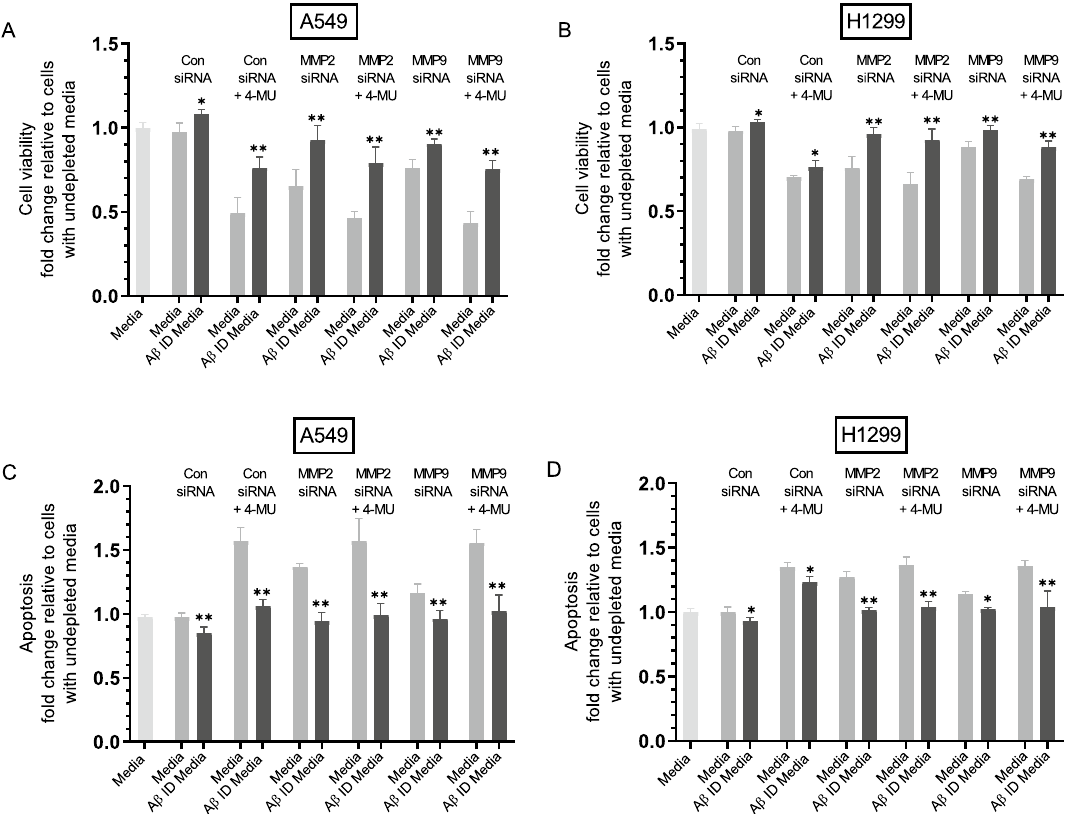
Figure 9. Treatment of either A549 or H1299 cells with MMP2/9 siRNA decreased cell viability and increased apoptosis, an effect reduced upon treatment with Aβ immunodepleted (ID) media. Aβ immunodepleted media (ID) was prepared by growing cells (0.2 × 10 5 ) in 10% FBS-supplemented media for 24 h. The cells were then incubated in serum-free media overnight then with the indicated treatments for 72 h. The media was then collected and depleted from Aβ sequentially using 6E10, Aβ40 and Aβ42 antibodies (“Methods” section). Viability and apoptosis of A549 and H1299 cells were assessed as described in the “Methods” section. Briefly, cells were seeded in 96-well plates at 0.2 × 10 5 cells per well in 10% FBS-supplemented media. The next day, the cell monolayers were incubated in serum-free media for 12 h, then treated with 300 μL of the control and Aβ ID media (0.5 μg/μL) for 72 h with the media containing the specific components in the various treatments replaced every 12 h. Data were processed using the GraphPad 8.4.3 software. The graphs summarize the results expressed as means ± SD (n = 3) of three separate experiments, each performed in triplicate. Asterisks (*) indicate a statistically significant difference between each treatment relative to non-depleted samples, Mann– Whitney test, * p < 0.05, ** p <